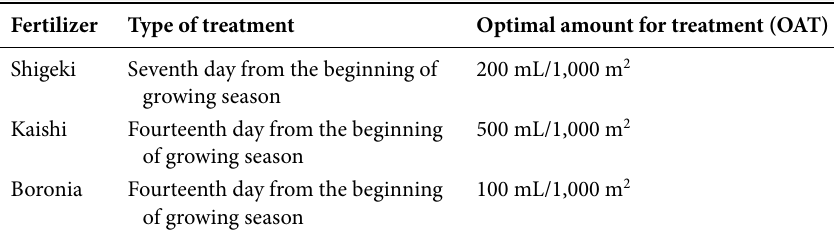
Table 1 Foliar fertilizers and type of